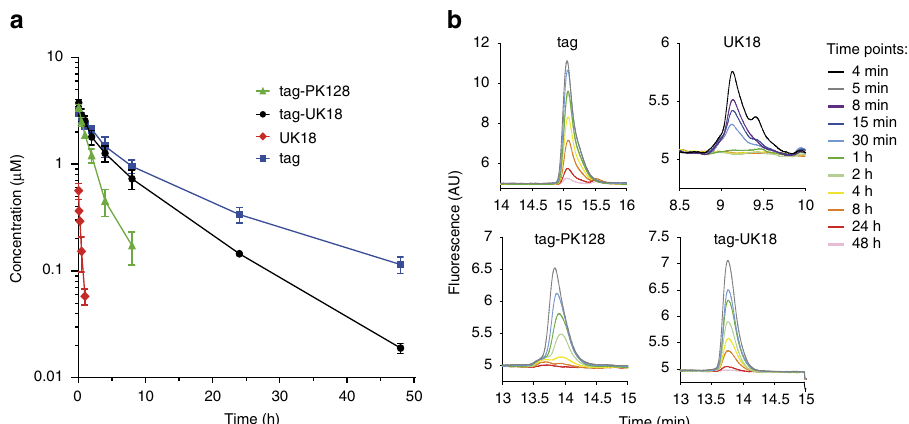
Figure 4 | Pharmacokinetic study in rats. ( a ) Concentration of peptides in rat plasma at indicated time points after i.v. administration of 0.5mgkg (cid:2) 1 tagged bicyclic peptides, 0.3mgkg (cid:2) 1 UK18 or 0.25mgkg (cid:2) 1 tag ( n ¼ 3). s.d.’s are indicated. ( b ) Analysis of peptides in rat blood samples by RP-HPLC using a fluorescence detector.